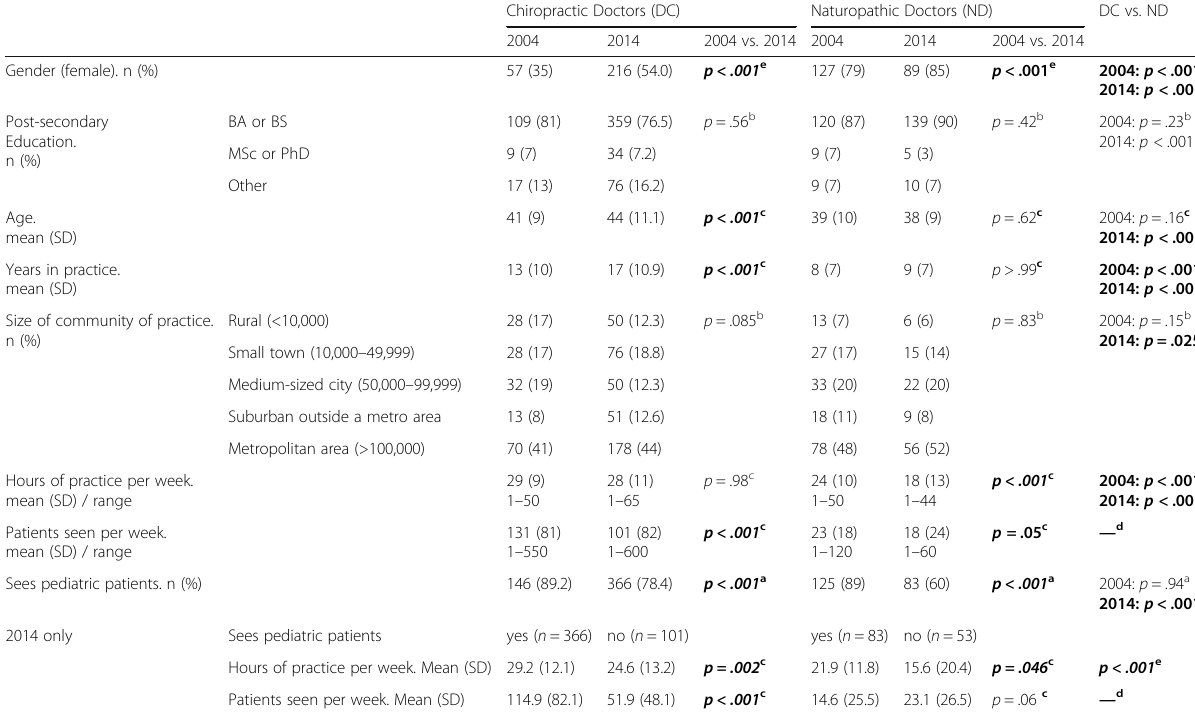
Table 1 Practitioner characteristics